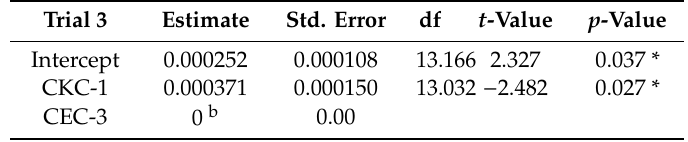
Table 19. The significant di ff erence of the mean of VR obtained in Trial 3 between CKC-1 and CEC-3. Trial 3 Estimate Std. Error df t -Value p -Value Intercept